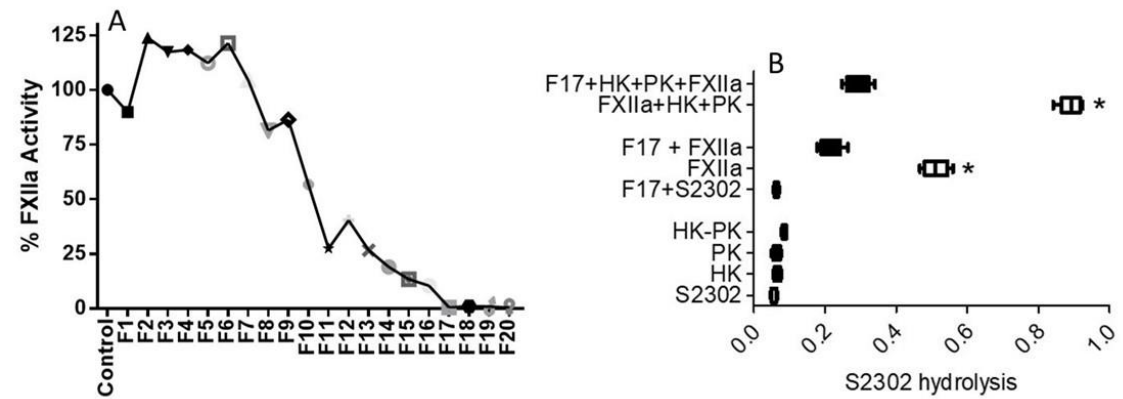
Figure 4. Showing the effect of biologically active compounds in tea on activated FXII ( A ) and FXIIa-induced prekallikrein (PK) activation ( B ) after HPLC separation. ( A ) Profile of anti-FXIIa activity in HPLC fractions. Each symbol indicates pNA formation in the presence of FXIIa (17 nM) supplemented with S2302 (0.5 mM). ( B ) pNA generation in HPLC fraction 17 supplemented with S2302 in the absence or presence of FXIIa or FXIIa and a mixture of HK and PK. The horizontal bars indicate means for each group ±1 SD. For all panels, results represent means for three runs (* p < 0.05 compared to F17-treated FXIIa).